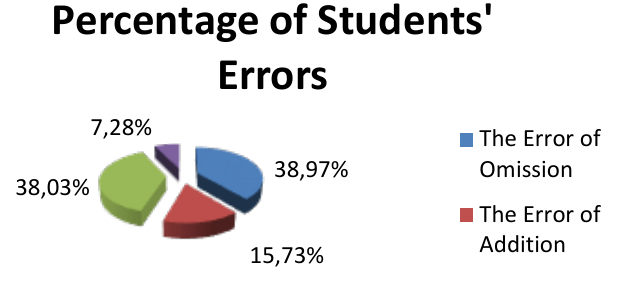
Figure 4.5. Percentage of Students’